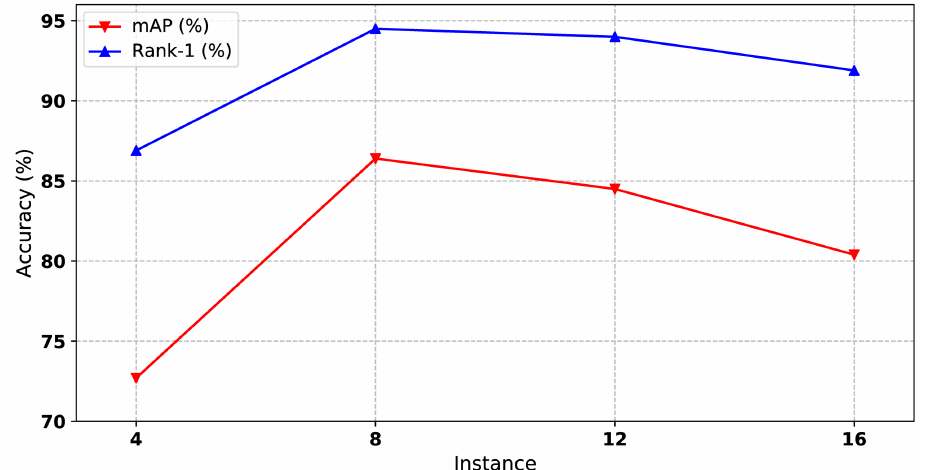
Figure 8. The impact of instance number to our method on Market1501 dataset. Both mAP and Rank-1 are used to evaluate the performance. The x-axis represents the number of instances for each